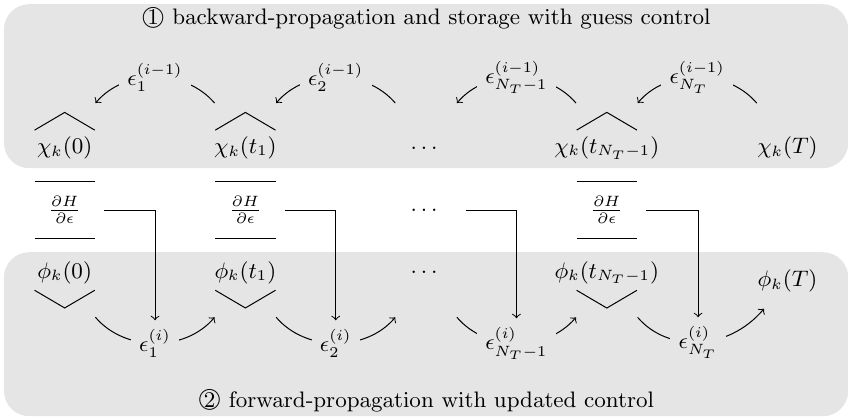
Figure 3: Sequential update scheme in Krotov’s method on a time